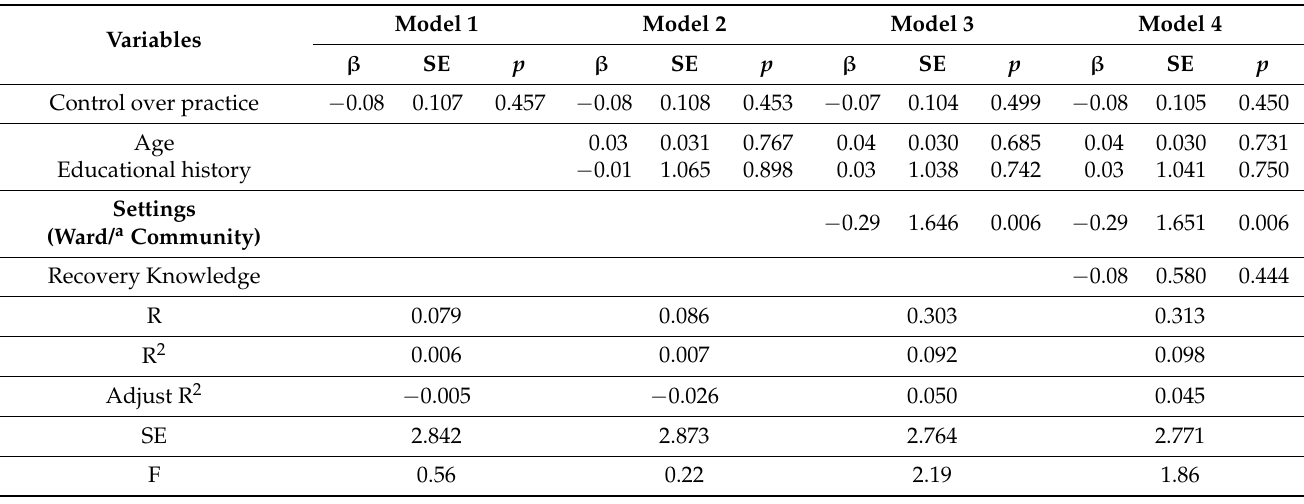
Table 4. The results of sub-group analysis among psychiatric social workers ( n =